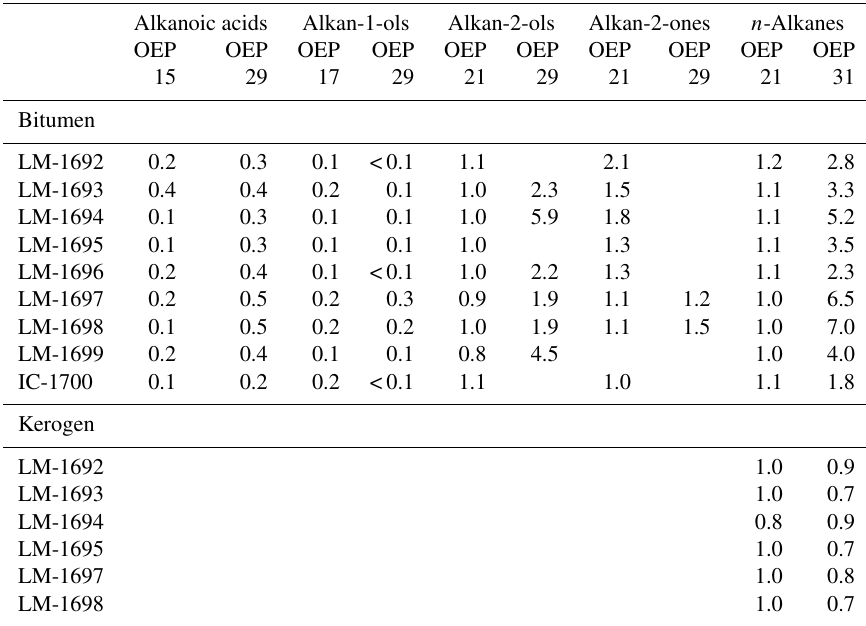
Table 3. Odd-to-even predominances (OEPs; Scalan and Smith, 1970) in bitumens and kerogens. Alkanoic acids Alkan-1-ols